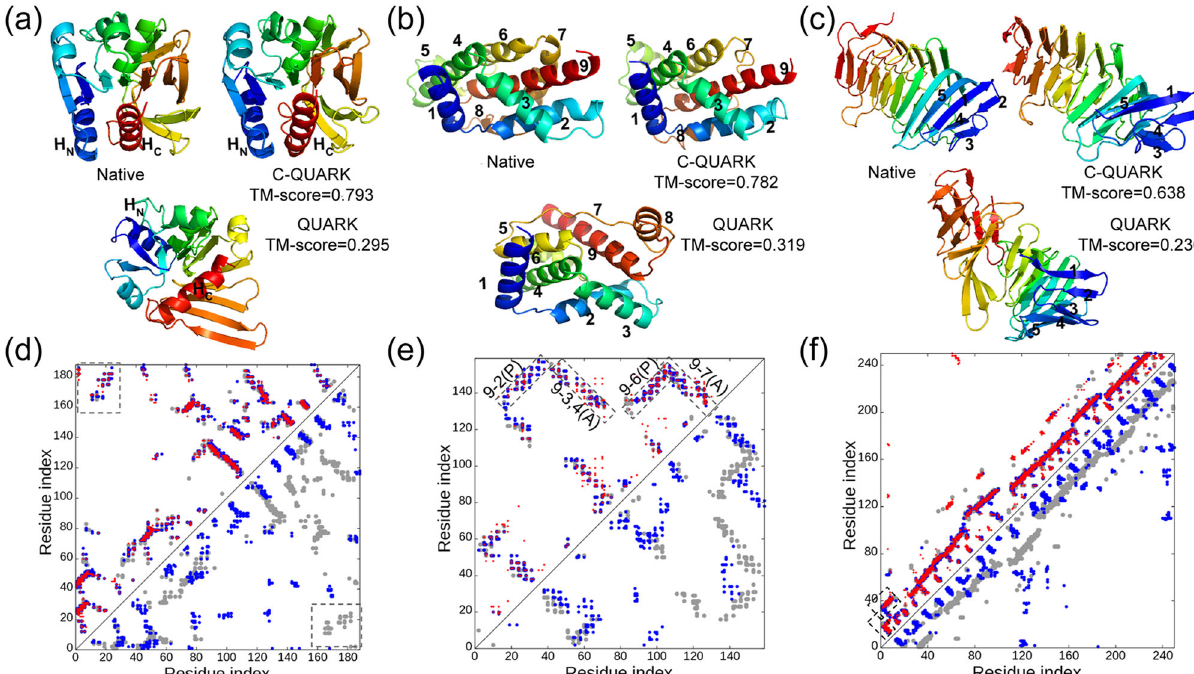
Fig. 3 Illustrative examples for contact-guided ab initio structure folding. a – c 3D structures for 2d7jA [https://doi.org/10.2210/pdb2D7J/pdb], 1y9iA [https://doi.org/10.2210/pdb1Y9I/pdb] and 4peuA [https://doi.org/10.2210/pdb4PEU/pdb], with blue to red running from N- to C-terminal. d – f corresponding contact-maps for the native structures (gray circles), predicted contacts (red circles), the contacts in the C-QUARK models (blue circles in the upper left triangles), and contacts in the QUARK models (blue circles in the lower right triangle). In a , d , H N and H C represent the N- and C-terminal helices, respectively, which are in contact in the native structure and C-QUARK model but not in the QUARK model, as highlighted in rectangles in the contact-map. In b , e , numbers indicate the order of helices from N- to C-terminal, where the contacts that contribute to the correct helix packing are highlighted by rectangles with ‘ A ’ and ‘ P ’ referring to anti-parallel and parallel, respectively, in the contact-map. In c , f , numbers indicate the order of the beta -strands at the N-terminal whose contacts are highlighted by rectangles in the